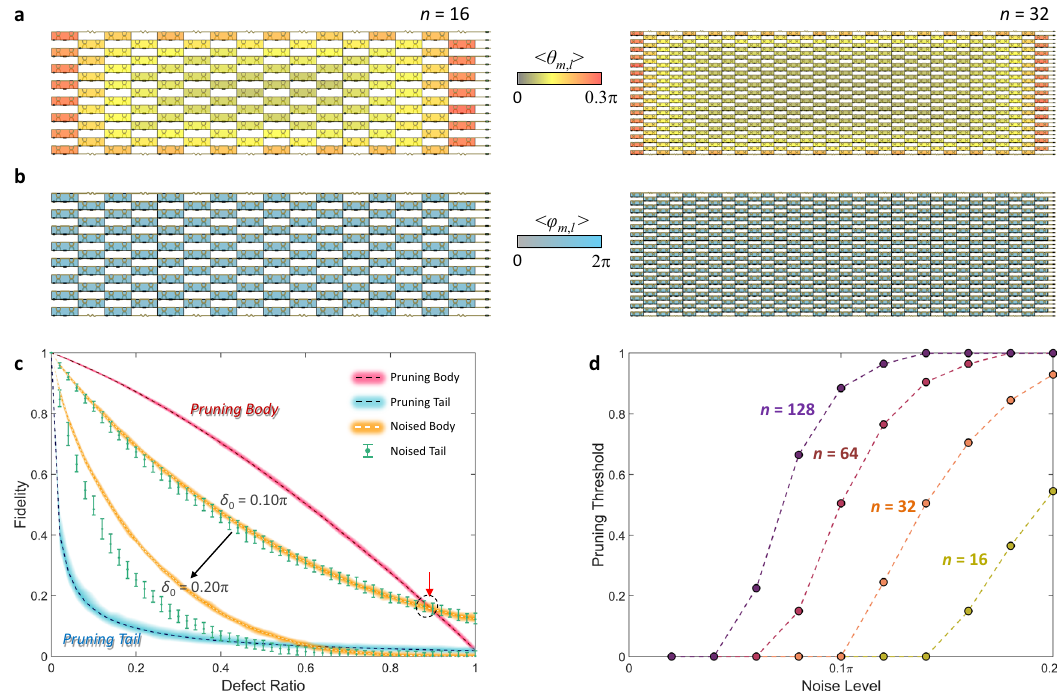
Fig. 4 | Universal architecture for pruning in recon fi gurable unitaries. a , b The averagesof< θ m , l >( a )and< φ m , l >( b )forthephotoniccircuitsof100 U n realizations with n =16and n =32.Wesettheupperboundofthecolormapin( a )tobe0.3 π for better visibility. c Comparison of the fi delities of the U 128 photonic circuits in dif- ferent groups: pruning body (red line), pruning tail (blue line), noisy body (orange line) and noisy tail (green error bars). The thicknesses of the colored lines and the